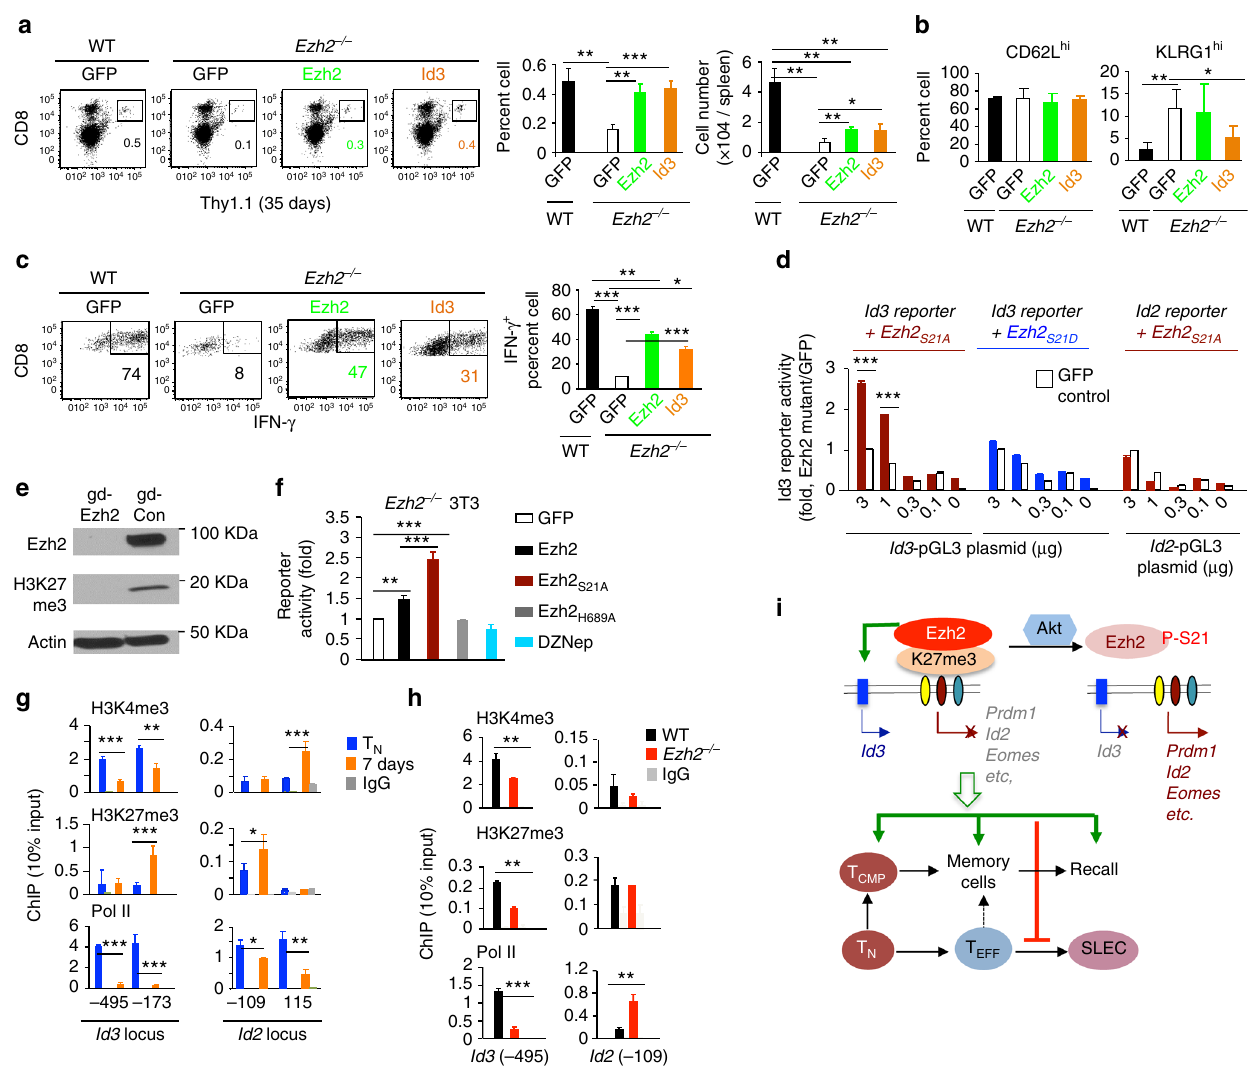
Fig. 8 Id3 is a downstream effector of Akt-unphosphorylated Ezh2 in CD8 + T cells. a – c WT and Ezh2 − / − T N Pmel-1 cells (Thy1.1 + ) were activated and infected with MigR1 encoding GFP, Ezh2, and Id3, respectively. By 7 days, GFP + T cells were sorted and transferred into sublethally irradiated B6 mice (Thy1.2 + , 5 × 10 5 cells per mouse). IL-2 and gp100/DCs were administered to these mice for 3 days after the transfer. Donor T cells were collected from the spleen 35 days after transfer to measure their percentage and numbers ( a ), surface phenotype ( b ) and production of IFN- γ ( c ). Dot plots and graphs in c show the percent of IFN- γ + cells within donor Thy1.1 + T cells. d 3T3 cells were transduced with an Id3 -speci fi c pGL3 luciferase reporter ( Id3-pGL ), together with MigR1-GFP, MigR1-Ezh2 S21A or MigR1-Ezh2 S21D . Id2 -speci fi c pGL3 luciferase reporter ( Id2-pGL ) was used as control. Graph shows the fold change of luciferase reporter activity. The data (mean ± SD) are representatives of three independent experiments. e , f 3T3 cells were transduced with pL- CRISPR.EFS.GFP plasmid or pL-CRISPR.EFS.GFP plasmid encoding guide RNA targeting Ezh2. 3 days later, GFP + cells were sorted into single cell using FACS sorter to select Ezh2-knockout cell clones. Immunoloblots show the loss of Ezh2 in 3T3 cells with Ezh2 knockout ( e ). These Ezh2-null 3T3 cells were reconstituted with MigR1-GFP vector and MigR1 encoding Ezh2, Ezh2 S21A or Ezh2 H689A . Id3-pGL luciferase reporter was introduced to these cells for reporter assay. In some experiments, WT 3T3 cells were treated with DZNep to deplete Ezh2 protein. Graph shows the fold change of luciferase reporter activity ( f ). g WT Pmel-1 cells were stimulated with anti-CD3/CD28 Ab + IL-2 for 7 days for ChIP analysis. Graphs show the deposition of H3K4me3, H3K27me3and Pol II at the promoter regions of Id3 and Id2. h WT and Ezh2 − / − T N Pmel-1 cells (Thy1.1 + ) were stimulated with anti-CD3/CD28 Ab + IL-2 for 7 days to perform ChIP analysis. i Graphic summary of Ezh2 effects on memory formation and function. * p < 0.05, ** p < 0.01, and *** p < 0.001 (two- tailed unpaired t test). The data are representatives of two experiments with n = 3 – 4 mice per group in each ( a – c , mean ± SD), or three independent experiments ( d – f , mean ±